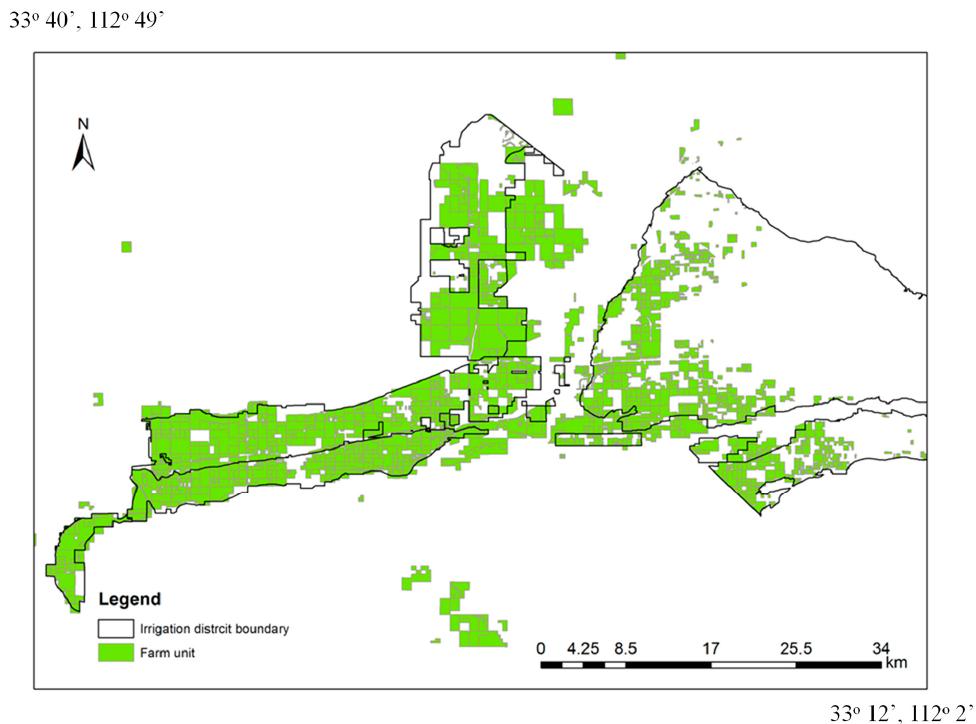
Figure 3. Farm units within and around several irrigation districts. The irrigation districts include ARLINGTON, BUCKEYE, ROOSID, MWD, AIWDD, SRVWUA, STJOHNS, and PENINSULA. Note that farm units can be located outside of any irrigation